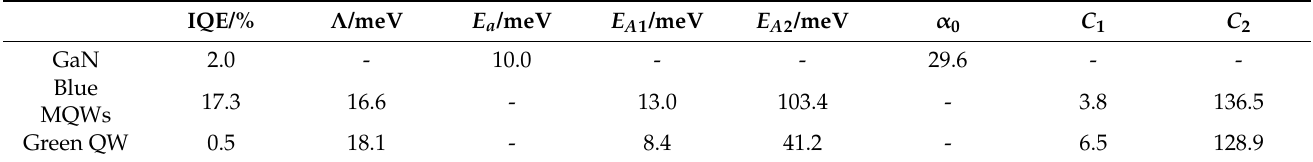
Table 2. The optical parameters: IQE; localization energy ( Λ ); activation energies ( E a , E A 1 and E A 2 ); defect densities ( α 0 , C 1 , and C 2